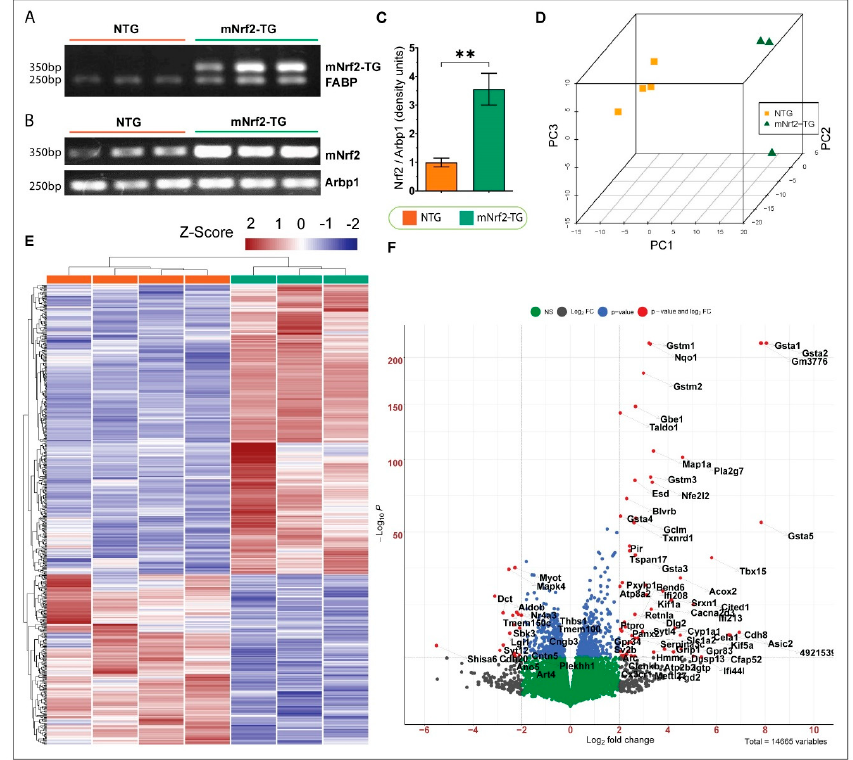
Figure 1. Heart specific Nrf2-Transgenic mouse model and transcriptomic changes. ( A ) Genotyping PCR for mNrf2-TG using α MHC forward and Nrf2 reverse primer (350 bp), (below) FABP (internal control) showed bands at 250 bp. ( B ) Semi-quantitative PCR for Nrf2 using primer for endogenous Nrf2 showing increased Nrf2 expression in Nrf2-TG compared to NTG mice; acidic ribosomal phos- phoprotein (Arbp1/Rplp0) was used as housekeeping. ( C ) Quantification of semi-quantitative PCR for Nrf2 using image. ( D ) Three-dimensional principal component analysis for mNrf2-TG and NTG mice. ( E ) Heatmap representing expression of the 680 most significant ( p < 0.05) differentially ex- pressed genes (Log2FC > 1). Some 428 genes were upregulated, and 251 genes were downregulated in mNrf2-TG mice. The heatmap represents normalized count values (RLog) of each DEG in the individual samples, and genes were clustered unsupervised. Fold change > 2 and p -value < 0.05. ( F ) Volcano plot of DEGs showing log2fold change versus − log10 of ( p -value) of transcripts identified by RNASeq analysis between NTG and mNrf2-TG. Significant DEGs expressed in mNrf2-TG (Log2FC ≥ 2 and p < 0.05) are highlighted in red (FDR corrected p -value). Blue dots indicate tran- scripts with a significant p -value but Log2FC ≤ 2; Grey dots indicate transcripts with a Log2FC ≥ 2 but with an FDR corrected p -value of <0.05; whilst green dots indicate non-significant transcripts with a Log2FC ≤ 2. The total number of genes amounts to 14,665. Error bars represent SEM. ** p - value < 0.01